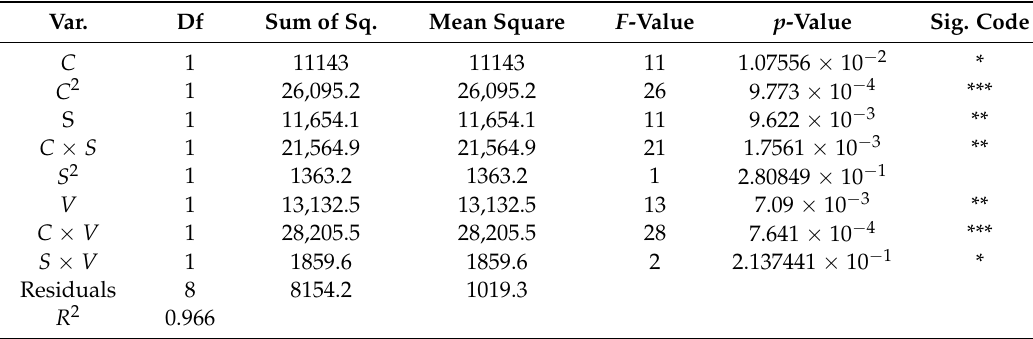
Table 7. ANOVA table for the “TS” quadratic